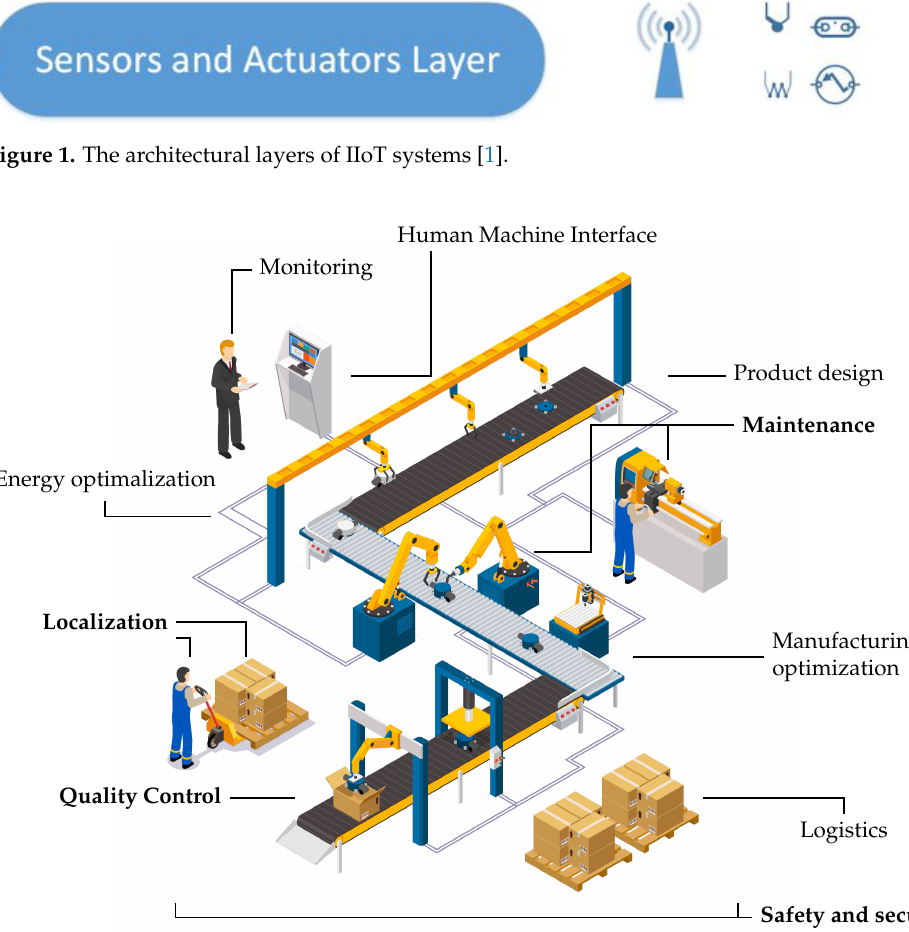
Figure 2. Production stages typically covered by the process of manufacturing. While machine learning can be applied in all areas of manufacturing, only a small subset of them use machine learning techniques extensively (shown in bold